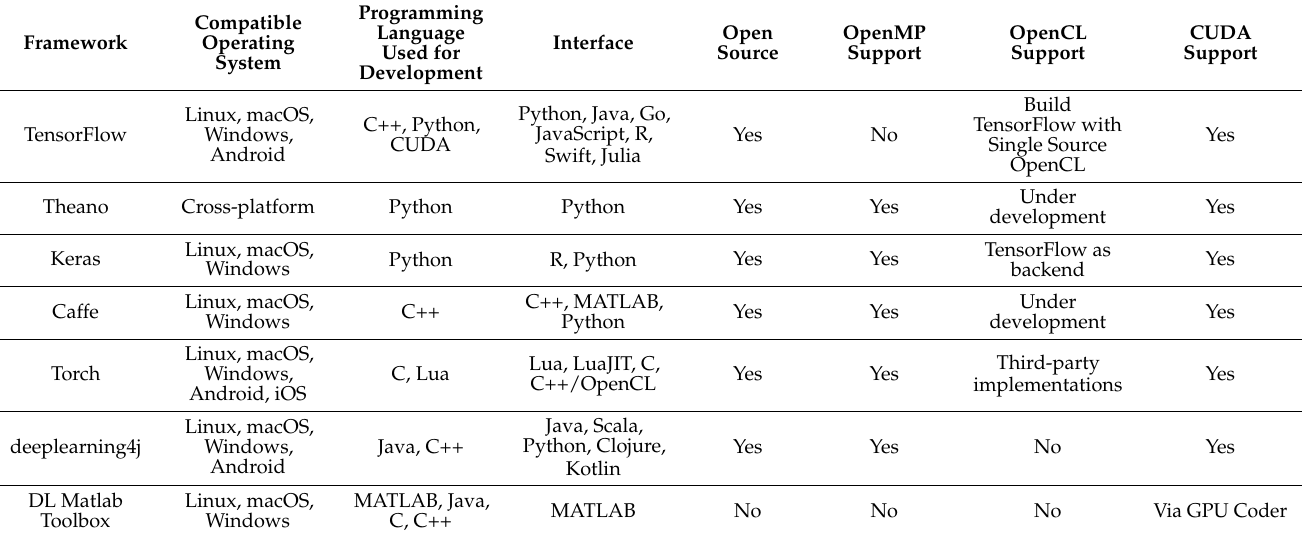
Table 5. Comparative analysis of CNN